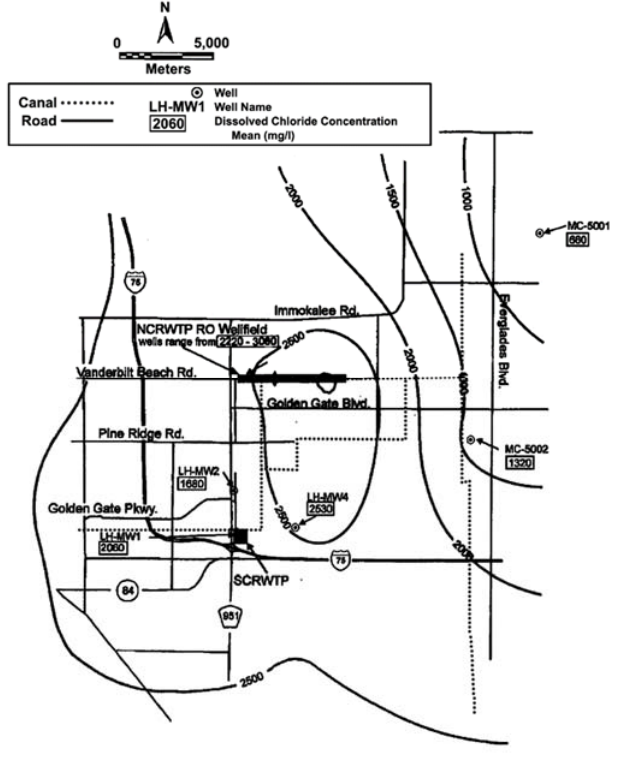
Figure 9. Dissolved chloride concentration distribution in the Lower Hawthorn Aquifer [32].